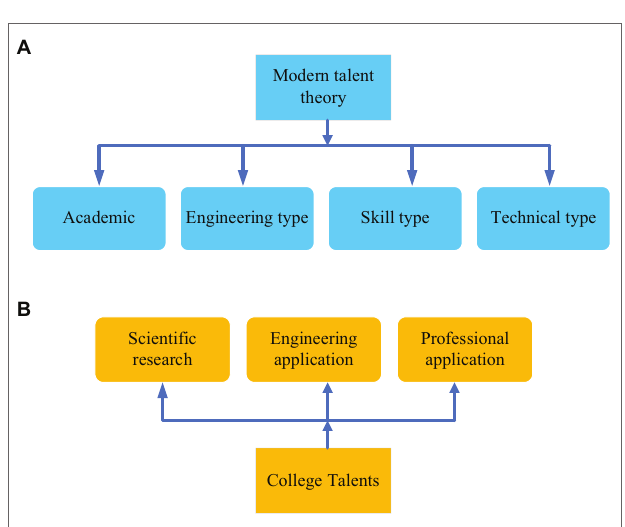
FIGURE 3 | Talents classification (A) Modern talent theory and (B) college Talents.